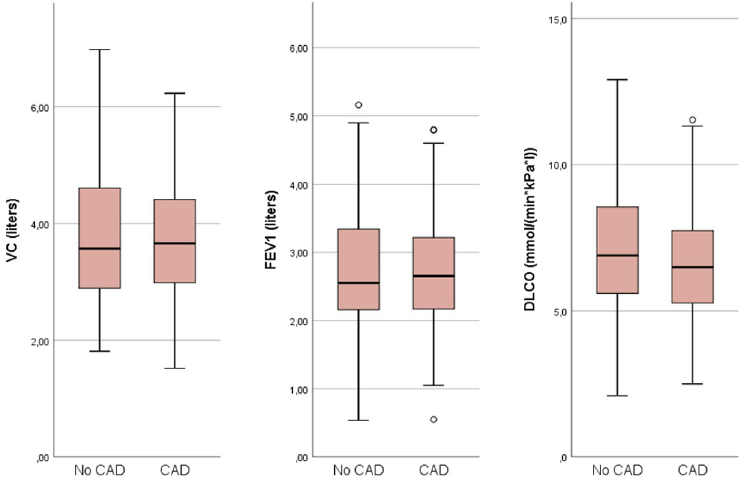
Fig 2. Lung function measurements in non-CAD vs CAD. VC = vital capacity; FEV 1 = forced expiratory volume in one second; D LCO = diffusing capacity for carbon